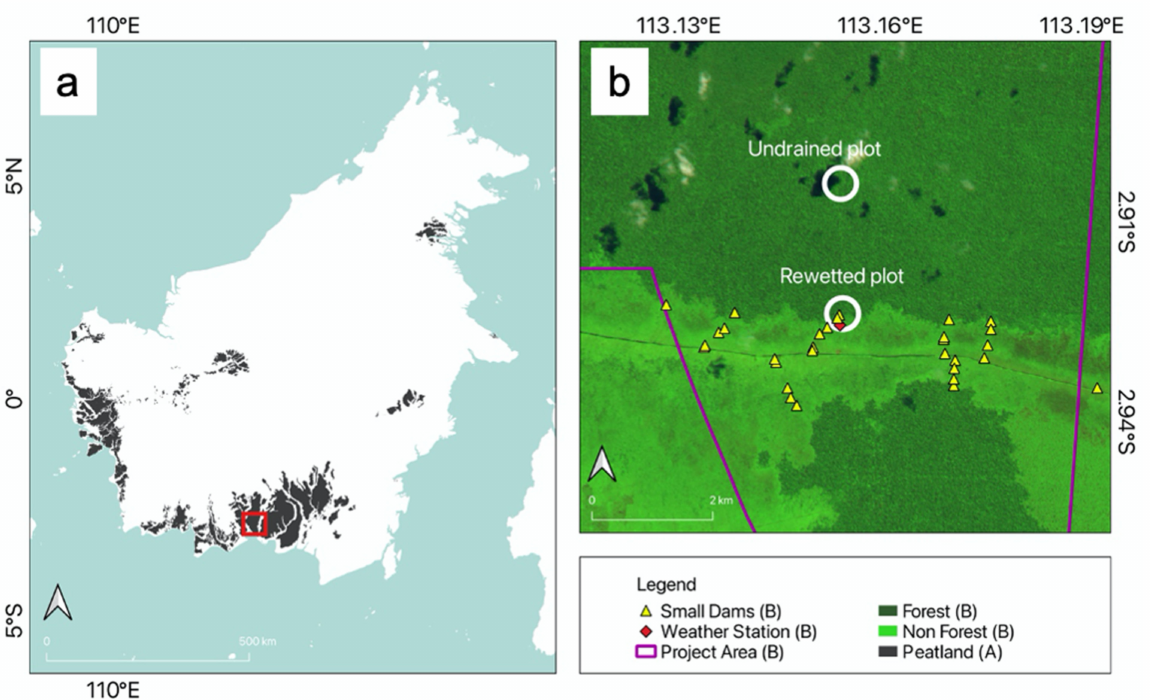
Figure 1. The study was conducted in the Katingan Mentaya Project area (red square) in Kalimantan, Indonesia (Panel a ). The rewetted and undrained sites (hollow white circle) are around 3 km apart (Panel b ). Yellow solid triangles indicate the ditch blocking built along the ditches. The red diamond indicates a weather station placed in an open area around 600 m from the rewetted site (Panel b